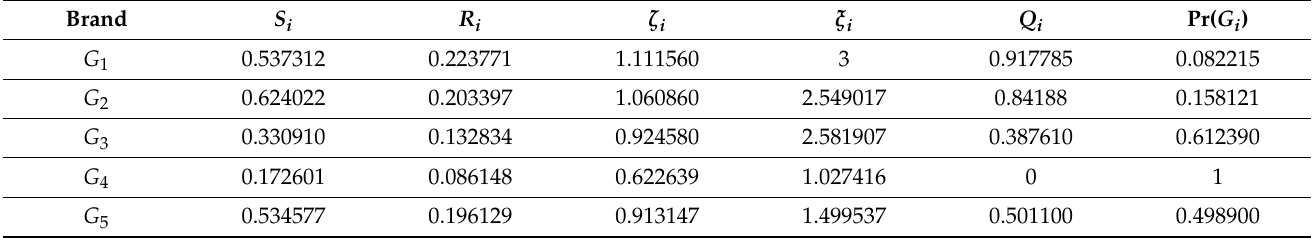
Table 12. The conditional probability value of each scheme based on improved VIKOR